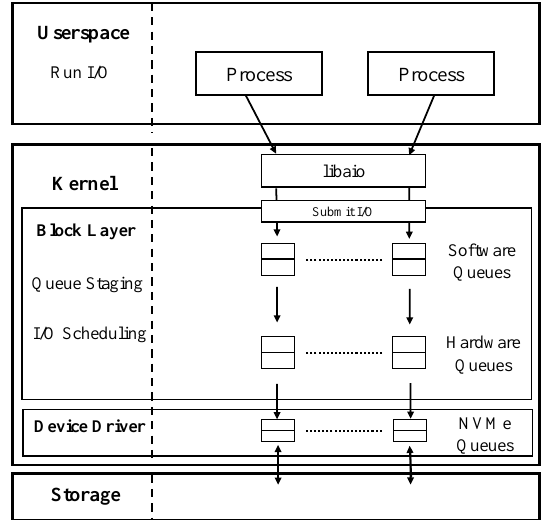
Figure 2. Multi-queue block layer in Linux